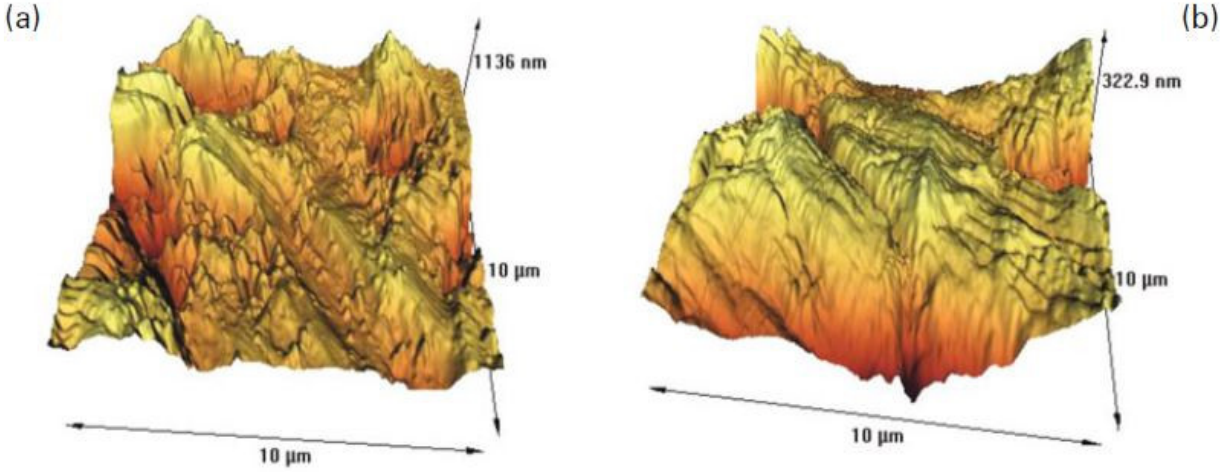
Figure 27. Three-dimensional AFM microphotograph images of a chalcopyrite surface ( a ) before and ( b ) after microwave radiation [159].